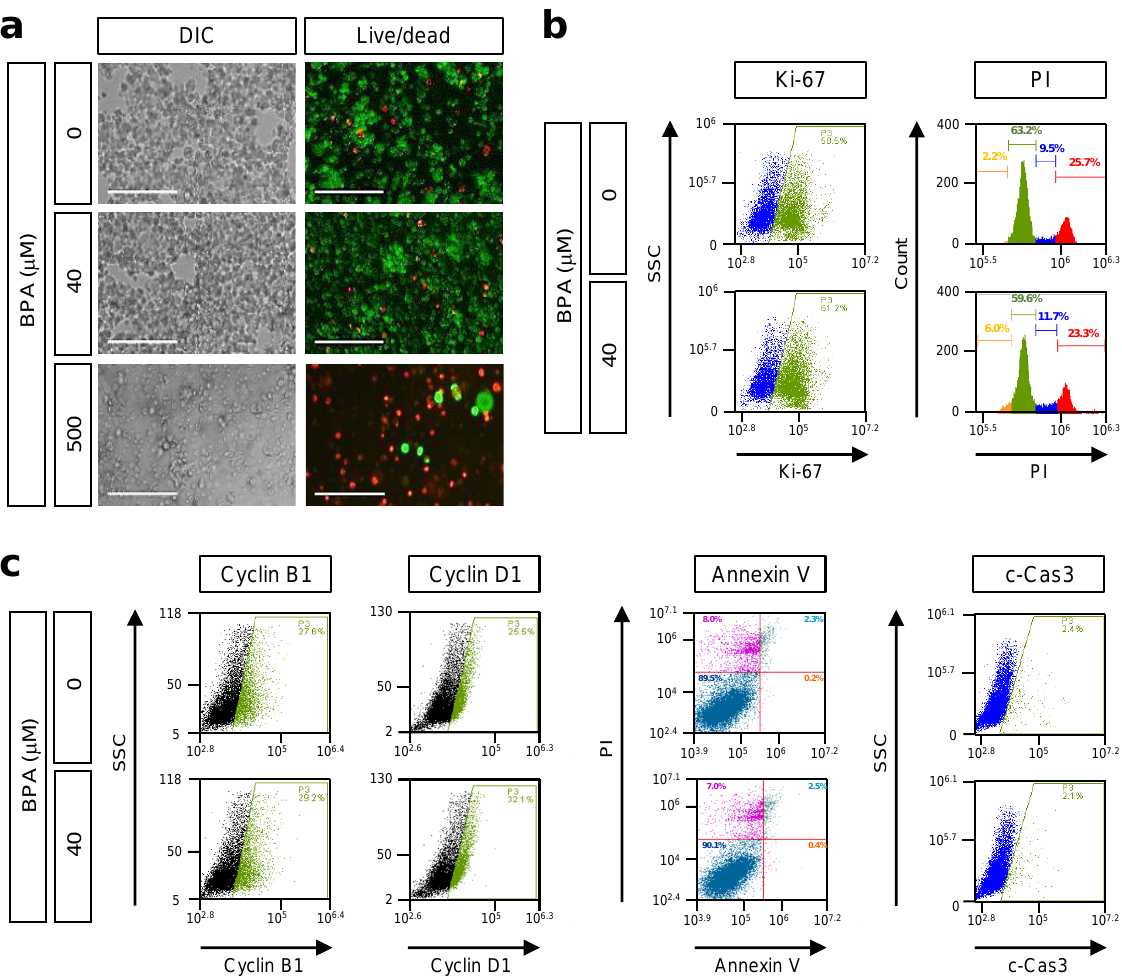
Figure 1. Cytotoxic effect of bisphenol A (BPA) on Y79 retinoblastoma cells. Cells were treated with the indicated concentration of BPA for 48 h. ( a ) Morphological changes in Y79 cells were observed by phase-contrast microscopy after BPA treatment. Cell viability was analyzed using the live/dead assay. Fluorescence microscopy images of live or dead cells after 30 min staining with calcein-AM (0.3 μM, Live cells) and EthD-1 (3 μM, Dead cells). Scale bars = 200 μm. ( b ) Cellular behavior by BPA treatment measured using FACS analysis. Cells were stained antibodies against each markers; Ki-67 for cell proliferation, propidium iodide (PI) for cell cycle. ( c ) Cyclin B1 and cyclin D1 for detection of cell cycle markers, Annexin-V/PI staining for apoptosis, cleaved Caspase-3 for detection of the active apoptosis. Values are presented as mean ± S.E.M., n = 6.